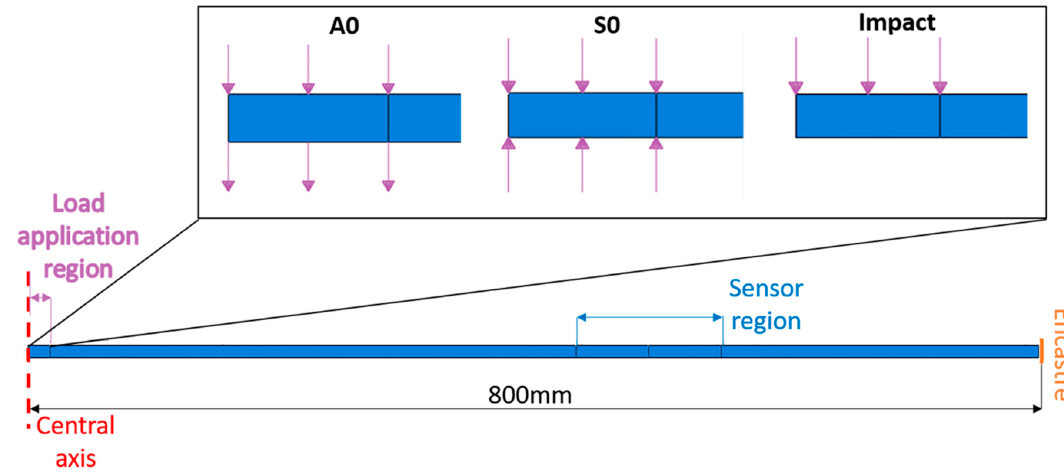
Figure 7. Schematic of the axis-symmetric Finite Element model (FEM) of the plate, with indication of the three different load configurations selected to model A0 and S0 Lamb wave propagation modes and the impact.